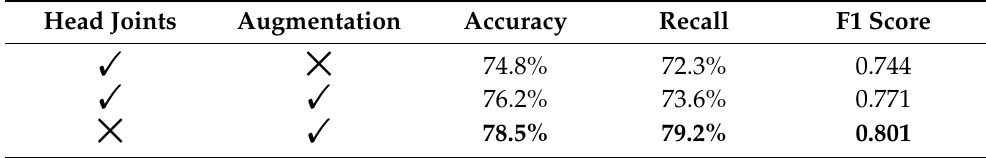
Table 2. Joints selection and data augmentation effects for ST-GCN.